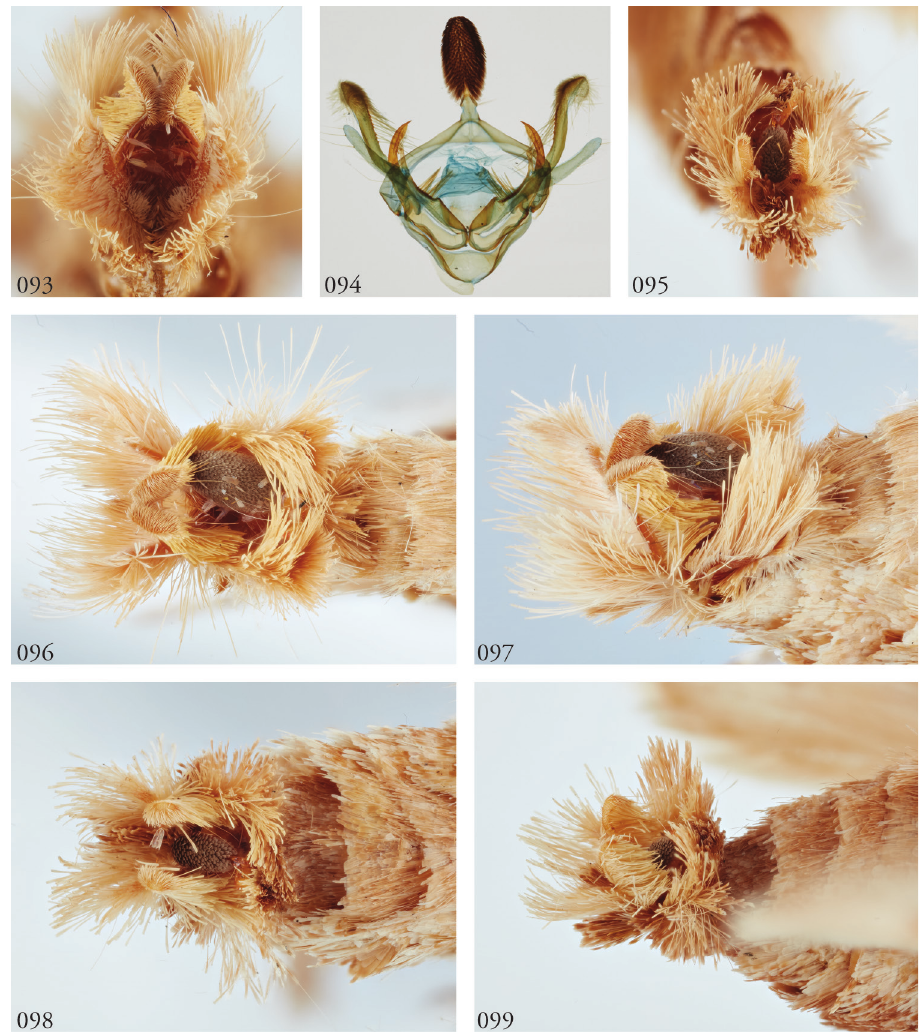
VZ 95 L. commixta , French Guiana, USNMENT01370327 96 L. tacita , Turrialba, Costa Rica, USN- MENT01370323 97 L. tacita , Turrialba, Costa Rica, USNMENT01370323 98 L. commixta , French Guiana USNMENT01370327 99 L. commixta , French Guiana,